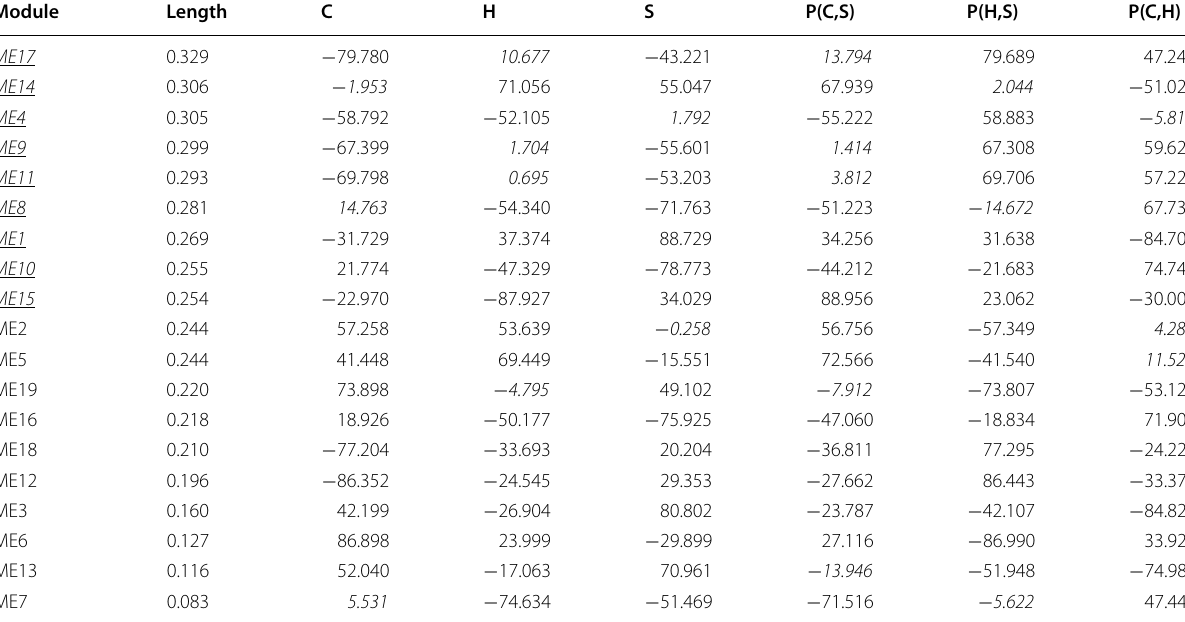
The italic underline gene modules had length greater than 0.25 The italics angles were less than 15 degrees